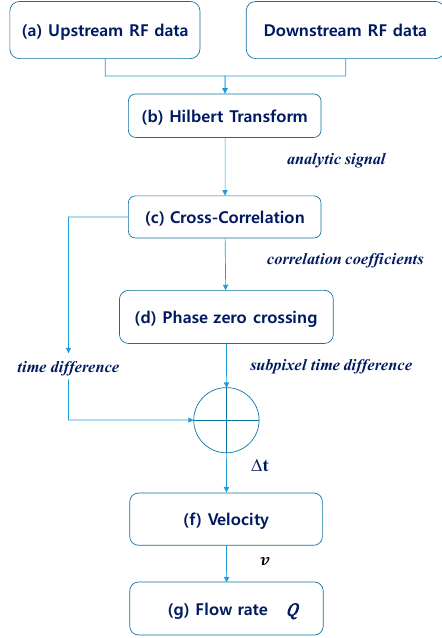
Figure 4. Flow estimation block diagram.